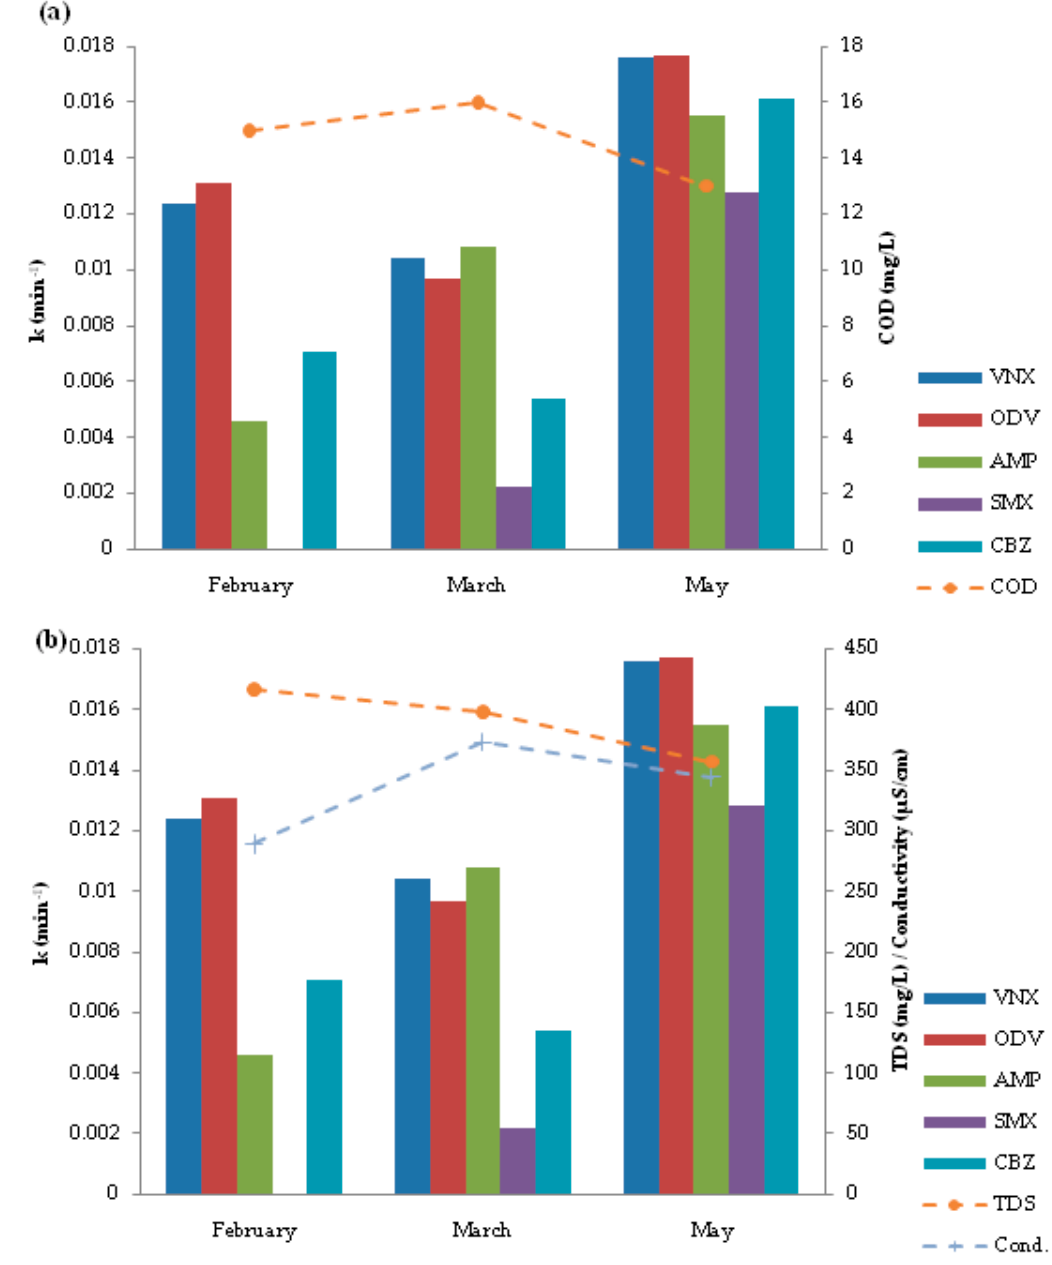
Figure 1. Degradation rate constants of pharmaceutically active compounds (PhACs) in relation with ( a ) chemical oxygen demand (COD) and ( b ) total dissolved solids (TDS) and conductivity, in TiO 2 suspensions in the three sampling months.